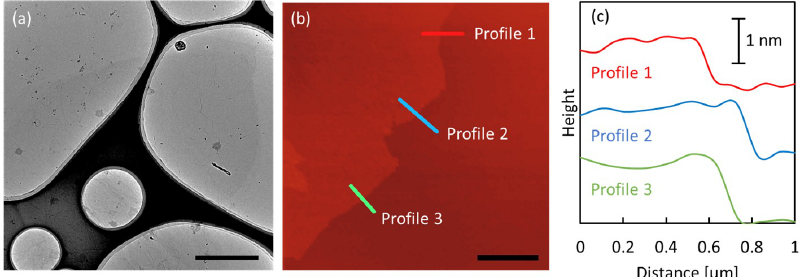
Figure 1. ( a ) Transmission electron microscope (TEM) image of graphene oxide (GO) nanosheets; ( b ) atomic force microscopy (AFM) image and ( c ) the corresponding depth profiles of GO nanosheets. Scale bar: ( a ) 2 µm; ( b ) 2 µm.